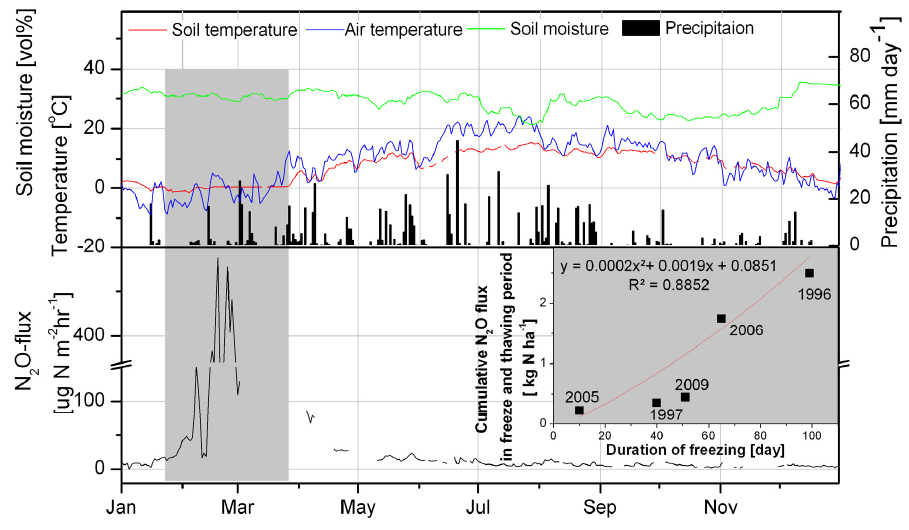
Fig. 4. Example for the temporal dynamics of daily N 2 O emissions in a year with freeze-thaw pulse N 2 O emissions (year 2006). The gray bar indicates the frost period (soil temperature at 5cm < 0 ◦ C). Daily air temperature (2m) and soil temperature (5cm), soil moisture (10cm) and the sum of precipitation are shown. The insert shows the cumulative N 2 O fluxes during and immediately following the freeze-thaw period in years with significant freeze-thaw N 2 O emission pulses.